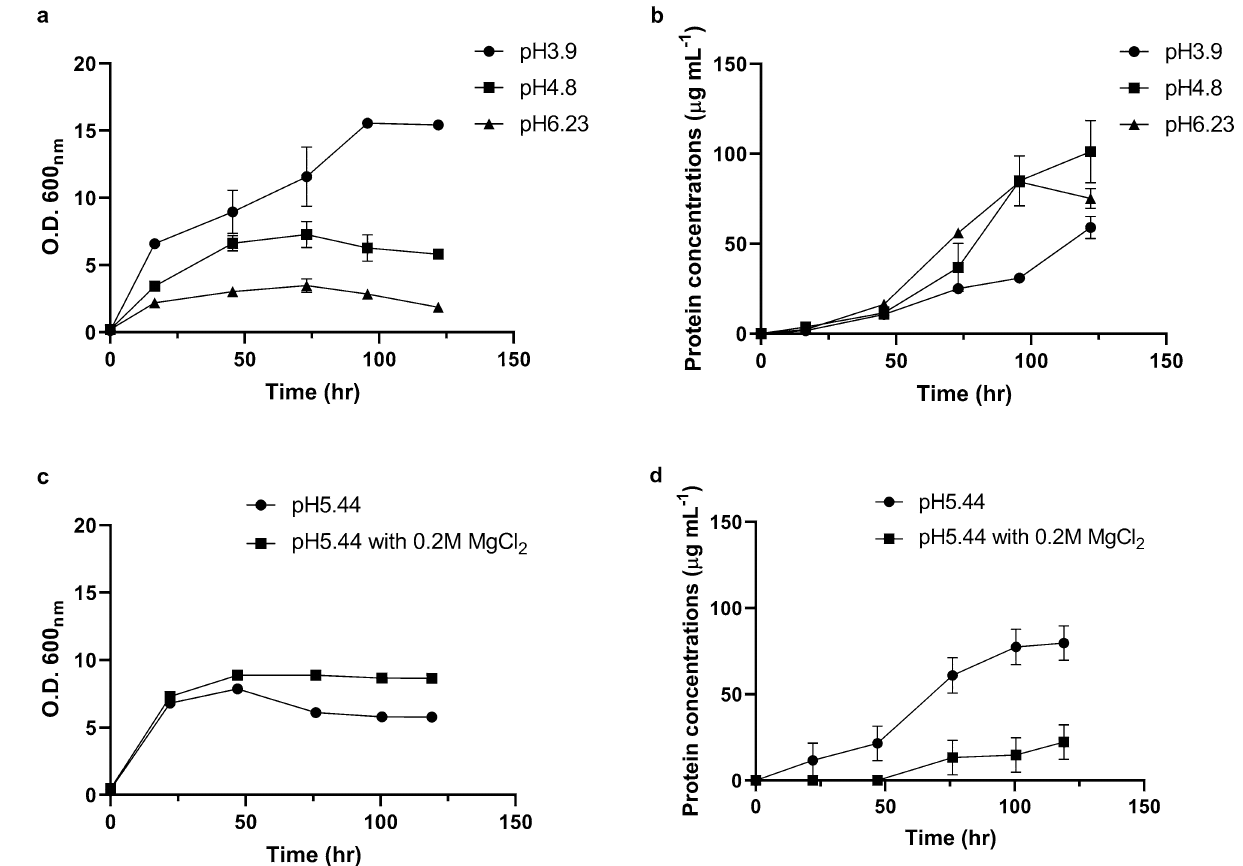
Figure 1. Growth curves and released protein concentrations of K. marxianus strain Bot3 + 7 at different pH values or with Mg supplementation. ( a ) Growth curve of K. marxianus strain Bot3 + 7 at pH 3.9, pH 4.8, and pH 6.23. ( b ) Released protein concentration of K. marxianus strain Bot3 + 7 at pH 3.9, pH 4.8, and pH 6.23. ( c ) Growth curve of K. marxianus strain Bot3 + 7 at pH 5.44 in the presence or absence of 0.2 M MgCl 2 . ( d ) Released protein concentration of K. marxianus strain Bot3 + 7 at pH 5.44 in the presence or absence of 0.2 M MgCl 2 . This image was created by using GraphPad Prism version 8.2.1 (https:// www. graph pad. com/ scien tific- softw are/